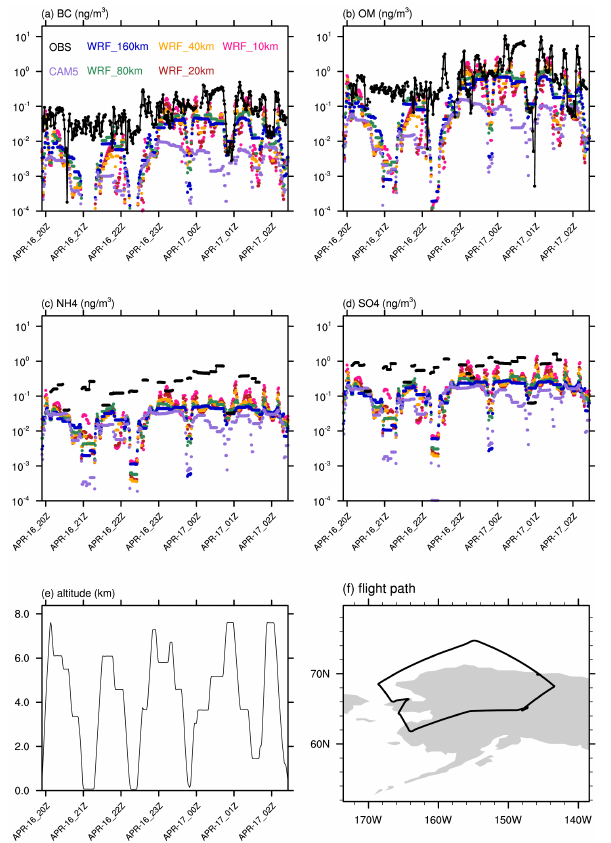
Fig. 5. The observed and simulated concentrations (ngm − 3 ) of (a) black carbon, (b) organic matter, (c) ammonium, and (d) sulfate at (e) altitude along (f) the DC-8 flight path on 16 April 2008, during the ARCTAS field campaign.